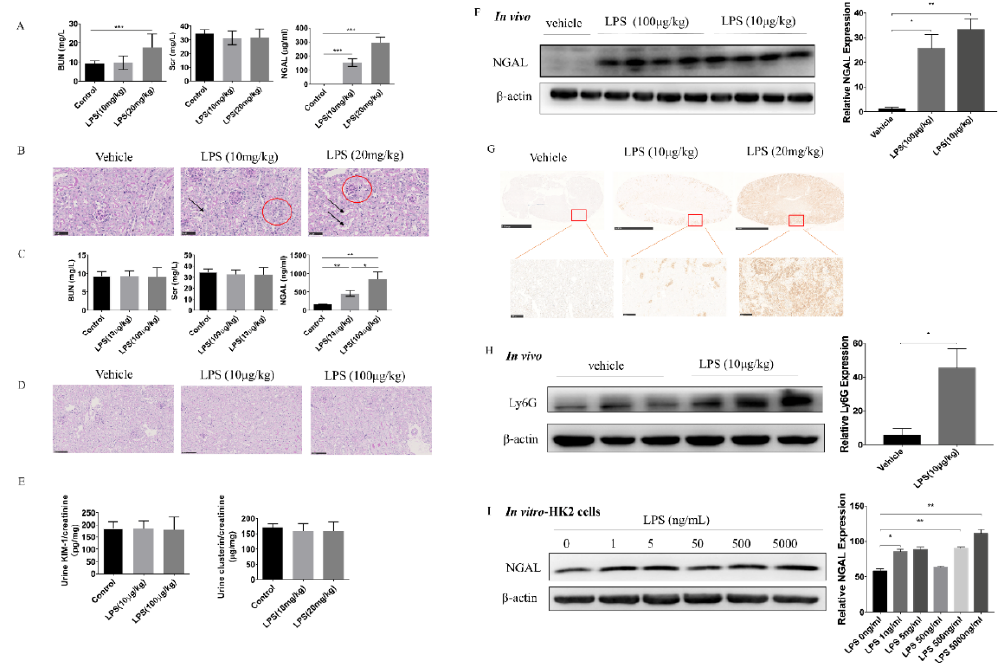
Figure 3. Serum NGAL is a sensitive and accurate biomarker to assess lipopolysaccharide (LPS)-induced kidney injury but is dependent on LPS dosage. ( A ) Concentrations of BUN, Scr, and sNGAL after a higher dosage of LPS intraperitoneal injection. ( B ) Representative figures of renal histopathology; arrows indicate slight tubule enlargement, and red circles refer to mononuclear cell infiltration. ( C ) Concentrations of BUN, Scr, and sNGAL after a lower dosage of LPS intraperitoneal injection. ( D ) Representative figures of renal histopathology from vehicle, 10 µ g kg − 1 , and 100 µ g kg − 1 LPS groups. ( E ) Ratio of kidney injury molecule-1 (KIM-1) / creatinine and clusterin / creatinine in urine from vehicle, 10 µ g kg − 1 , and 100 µ g kg − 1 LPS groups. ( F ) NGAL protein levels from kidney tissues were determined by western blot. ( G ) Representative figures of immunohistochemistry of NGAL in vehicle, 10 µ g kg − 1 , and 20 mg kg − 1 groups. ( H ) Ly6G protein level in kidney tissues in the 10 µ g kg − 1 group was determined by western blot. ( I ) NGAL protein levels from Human kidney-2 (HK-2) cells stimulated by LPS were determined by western blot. *, p < 0.05, **, p < 0.01, ***, p < 0.001 ( n = 8 for each subgroup).